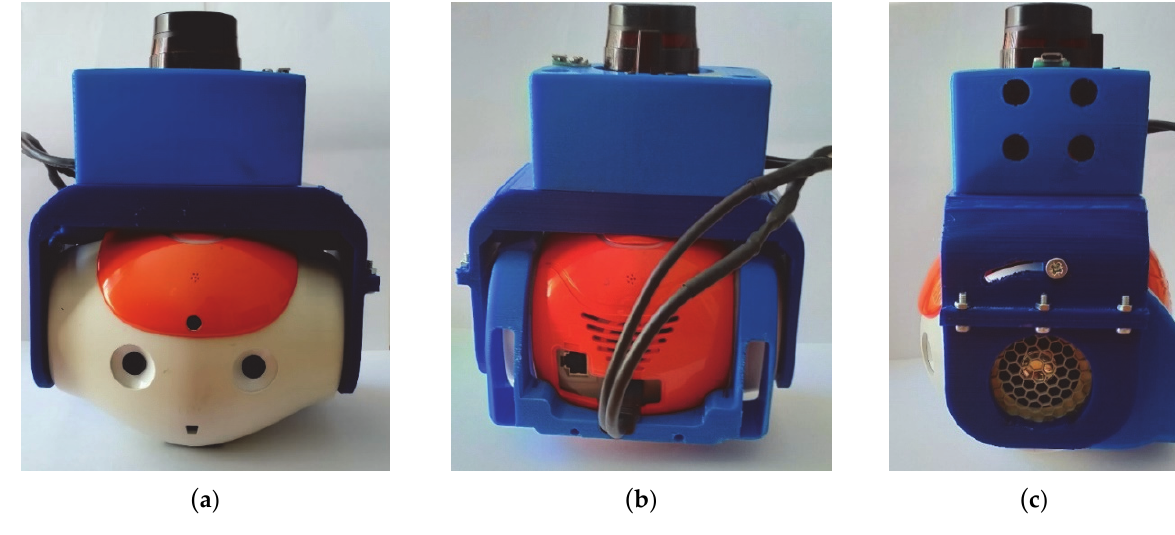
Figure 7. Helmet on the robot’s head: ( a ) front, ( b ) rear, and ( c ) side view.